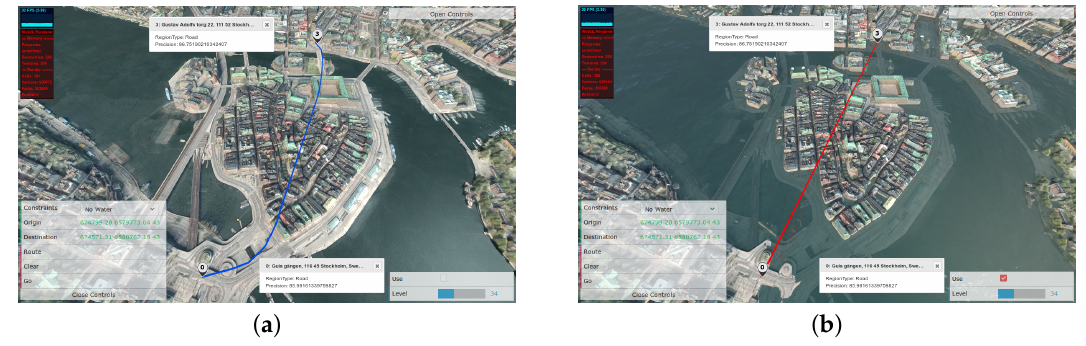
Figure 10. The same region of Stockholm in flooded and non-flooded conditions. The points 0 and 3 are the start and the destination points respectively. They are located on the different islands but there are possible paths between them through the bridges. ( a ) Non-flooded condition: the path finder is able to find a path with a “no water” constrain, using a bridge; ( b ) Flooded condition: the path finder is not able to find any path, because the destination point is located in the flooded